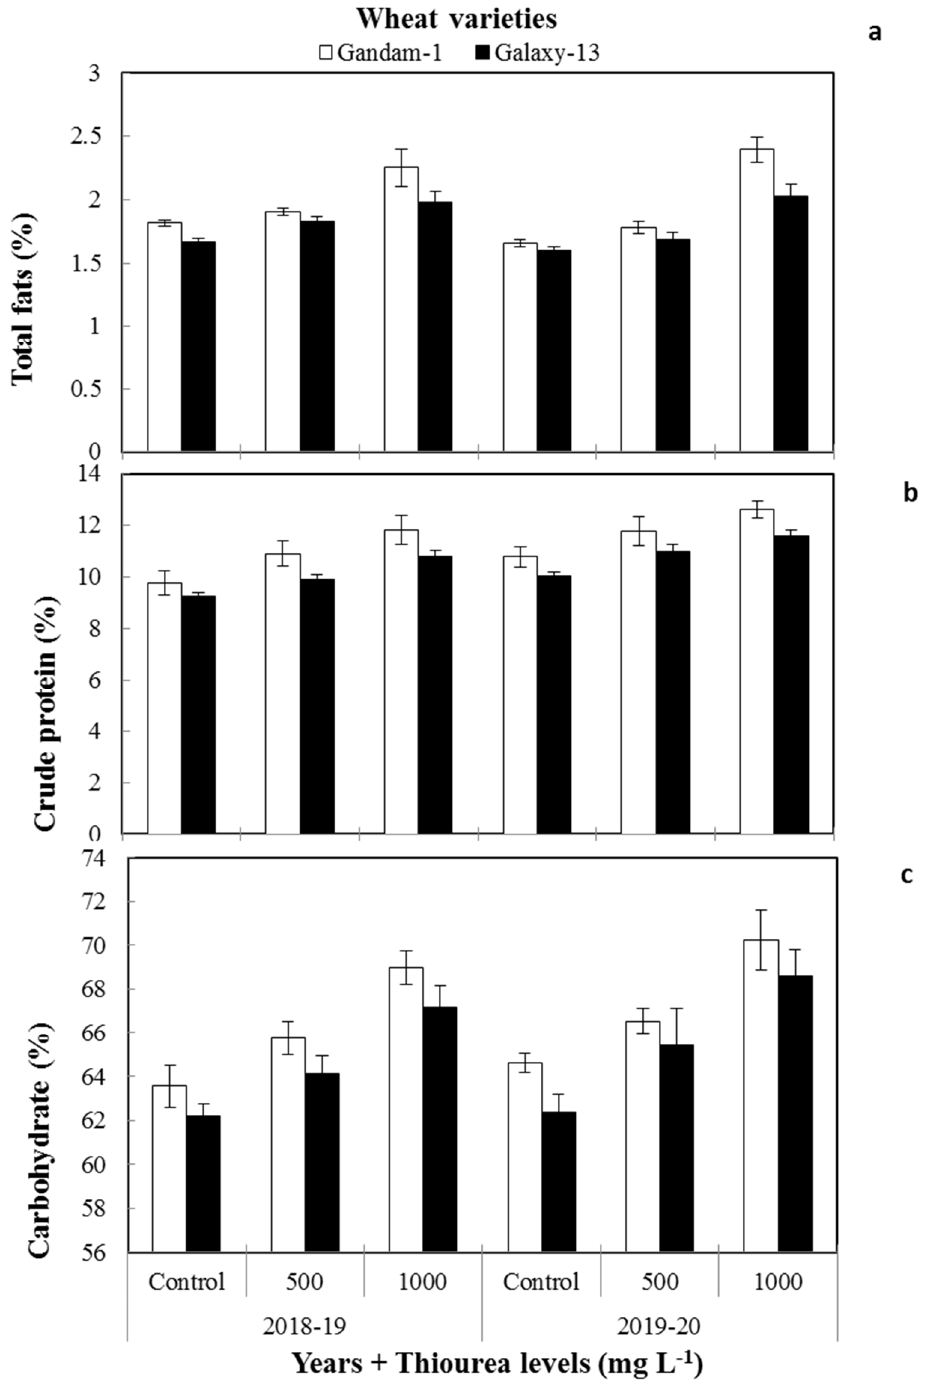
Figure 2. Interactive effect of varieties × thiourea on the nutritional quality of bread wheat grains grown in a semi-arid environment. a, total fats; b, crude protein; c, carbohydrate. Error bars represent the standard error ( n = 5) during 2018–2019 and 2019–2020.